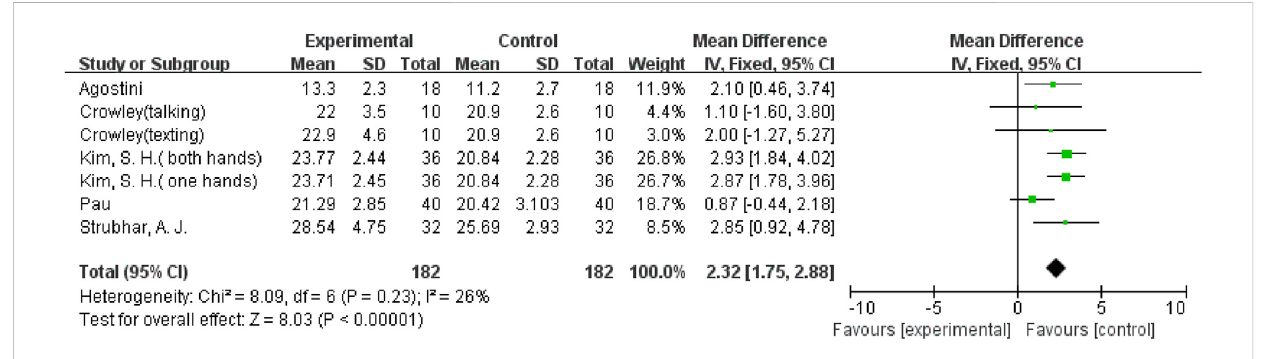
FIGURE 8 The effect of mobile phone use on double support (%